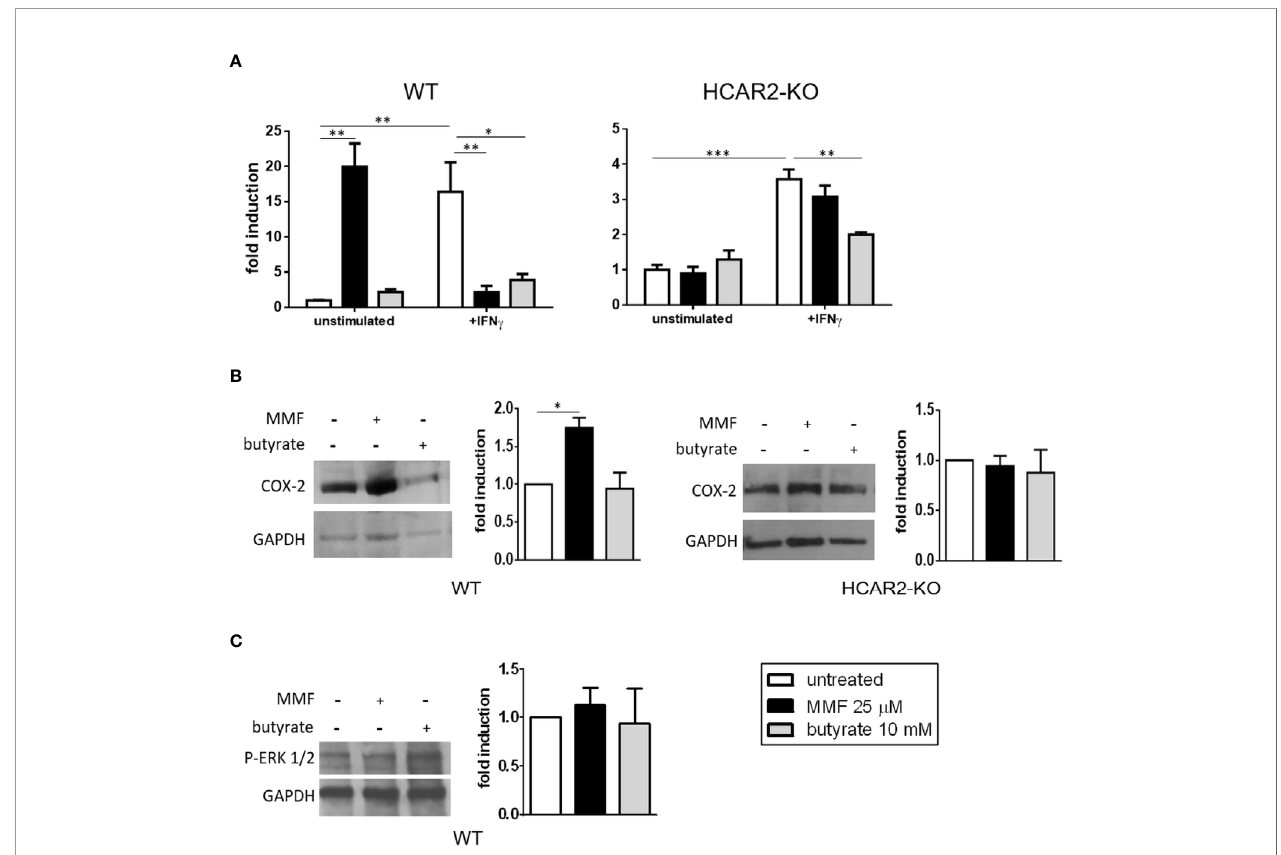
FIGURE 2 | Under non-in fl ammatory conditions, MMF signals through the HCAR2/COX-2 pathway to increase the mRNA expression of the pro-in fl ammatory Tnf in IEC. (A) MMF differentially affects Tnf expression in IEC under different conditions of activation. Tnf mRNA expression in IEC isolated from WT (left panel) or HCAR2- KO (right panel) mice and activated or not with IFN g (100 ng/ml), in presence or absence of MMF or butyrate for 6 h. (B) MMF, but not butyrate, induces COX-2 in unstimulated IEC, via HCAR2. Western blotting for COX-2 in IEC isolated from WT (left panels) and HCAR2-KO (right panels) mice treated or not with MMF or butyrate for 6 h. (C) MMF does not activate HCAR2/ERK1/2 pathway in unstimulated IEC. Western blotting for P-ERK1/2 in IEC isolated from WT mice treated or not with MMF or butyrate for 6 h. Representative blots and densitometric quanti fi cation graphs are shown. Real-time PCR data are presented as fold induction over the expression of the gene in untreated cells. GAPDH was assessed as loading control for Western blotting and quanti fi cation by densitometric analysis of bands is presented as COX-2 over GAPDH (B) or p-ERK1/2 over GAPDH (C) . All results are shown as mean ± SEM of at least N = 3 experiments. * P < 0.05, ** P < 0.01, and *** P <